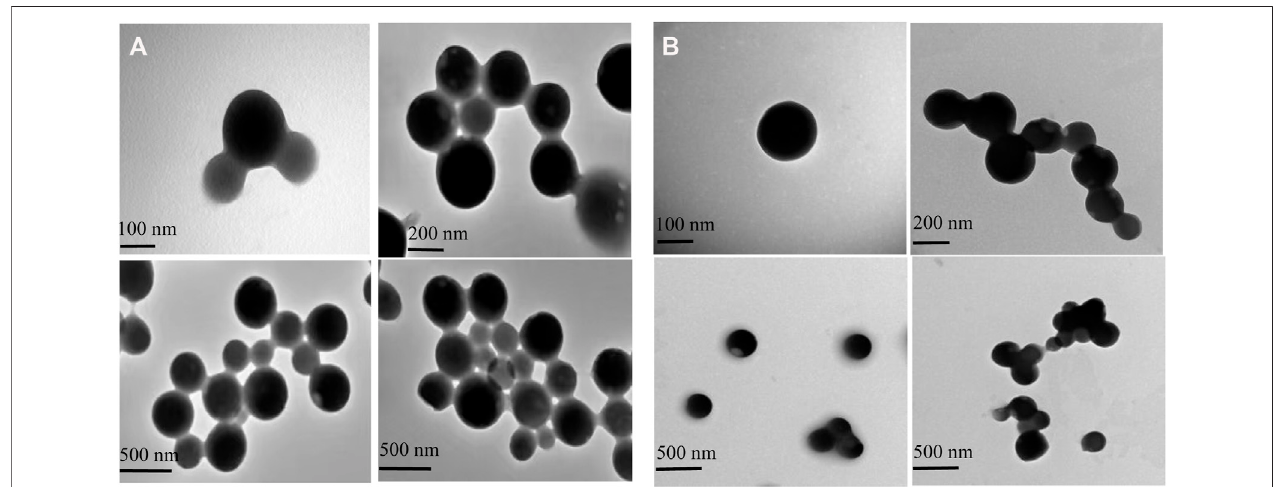
FIGURE3| Transmissionelectronmicroscopy(TEM)imagesofZH-LUT (A) andGZH-LUT (B) .ThefreshlypreparedZH-LUT,GZH-LUTnanoparticleswerediluted 20times withwater,andadropofthediluted nanoparticles wasplacedona200meshcarbon-coatedcopper grid.Images ofthenanoparticlesweretakenat100 kVat a certain magni fi cation. The scale bar represents 100, 200, and 500 nm in both (A) and (B) .